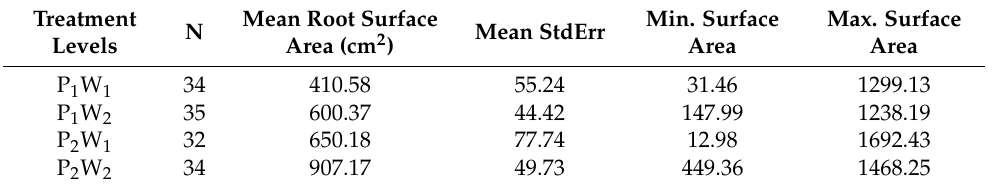
Table 11. Effects phosphorus–water treatments on root surface area (cm 2 ) of common bean.